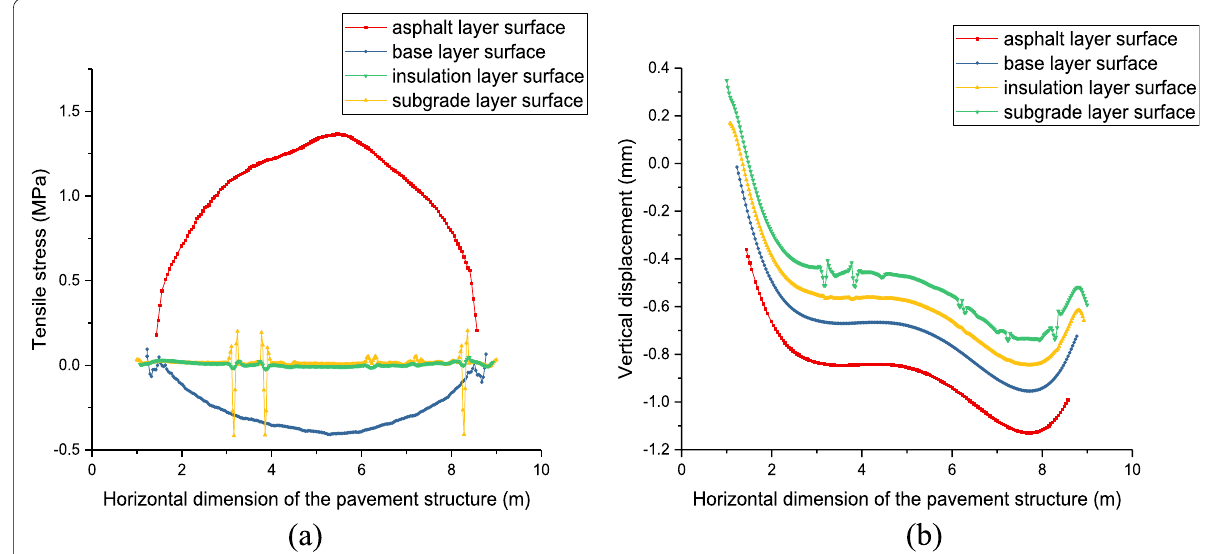
Fig. 11 a The tensile stress and b the vertical displacement in the pavement structure with polyurethane insulation layer on March 1st, 2017 at Anchorage, Alaska